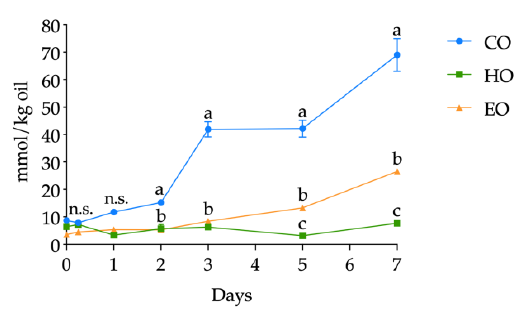
Figure 4. Kinetics of peroxide value (PV) (meq O 2 / kg oil) in stripped linseed oil without antioxidants (CO), with hemp extract (HO), and with α -tocopherol (EO) and results of ANOVA with Duncan’s test. Each point corresponds to the mean ± standard deviation ( n = 3). Di ff erent letters a,b within the same day mean significantly di ff erent results at p < 0.05 among di ff erent samples. n.s. = not